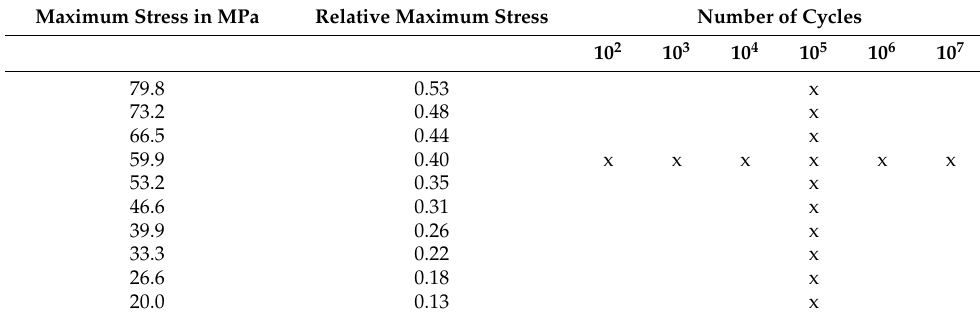
Table 1. Test matrix of fatigue preloading.